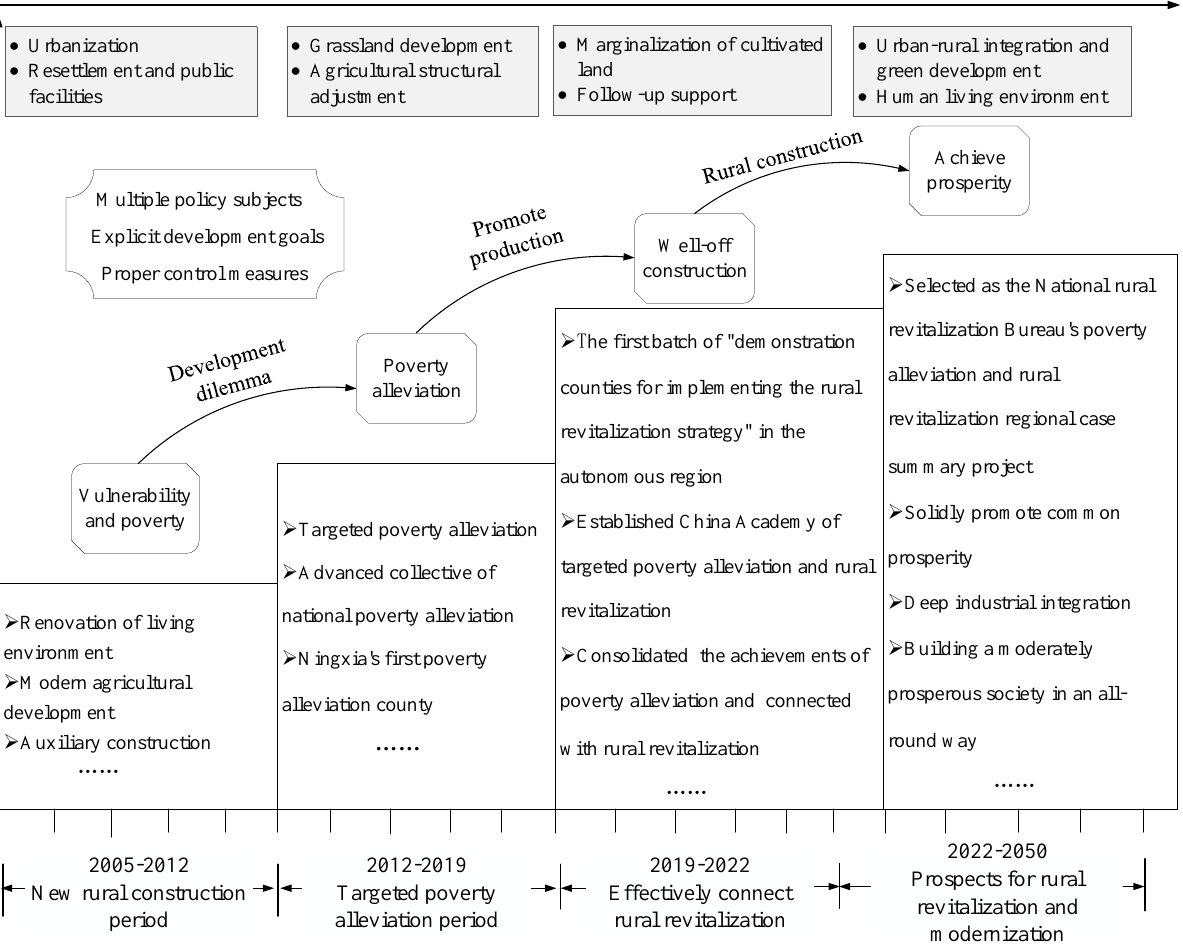
Figure 4. Poverty alleviation and rural revitalization in Yanchi County.